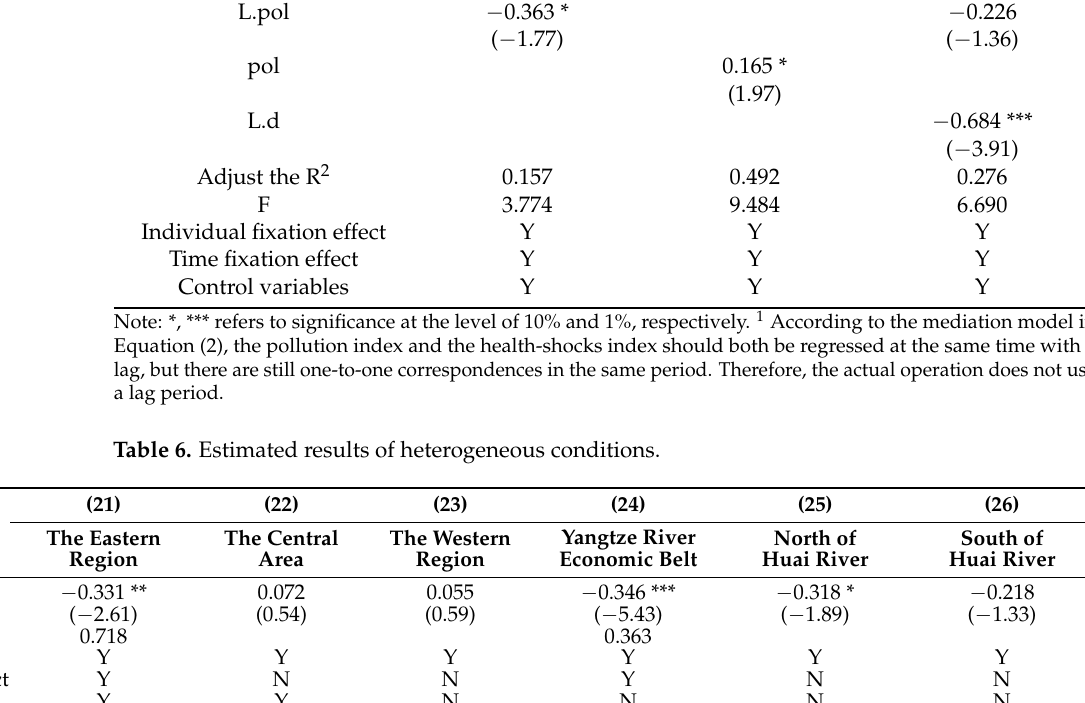
Table 5. The robustness test results of the mediation model. Var.